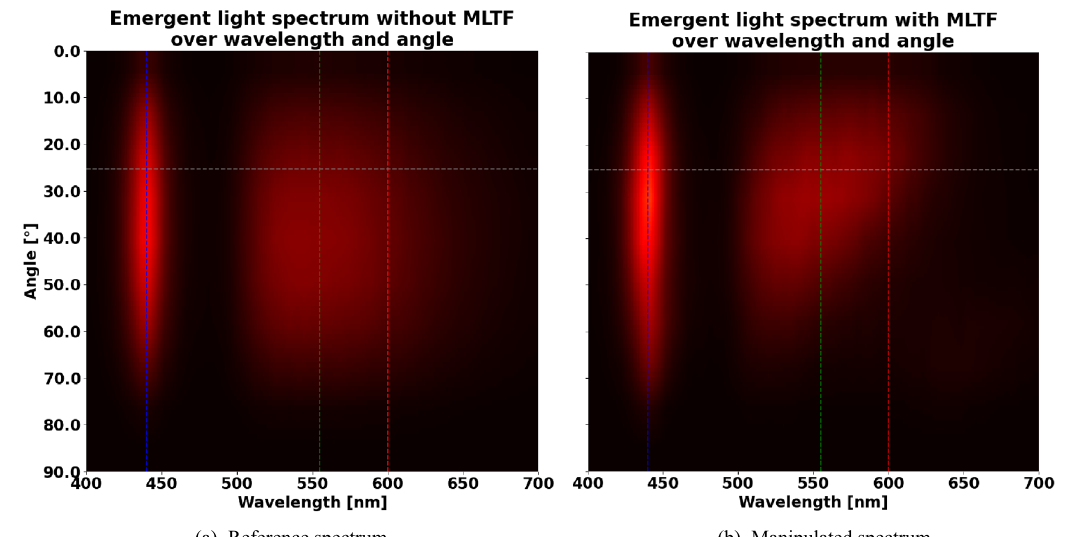
Figure 5. ( a ) Common angular and spectral distribution of relative power of a white LED without a multi-layer thin film. ( b ) Spectrum of a white LED with a multi-layer thin film that contains 28.9% more relative power compared to the reference design in forward direction. In each case, the blue chip wavelength ( 440 nm ) and the green and red wavelengths ( 555 nm ) and 600 nm ) of the conversion materials are indicated by vertical dashed lines. The horizontal grey line indicates the ± 25 ◦ -forward direction. The color map for the heat maps coincides with Fig.